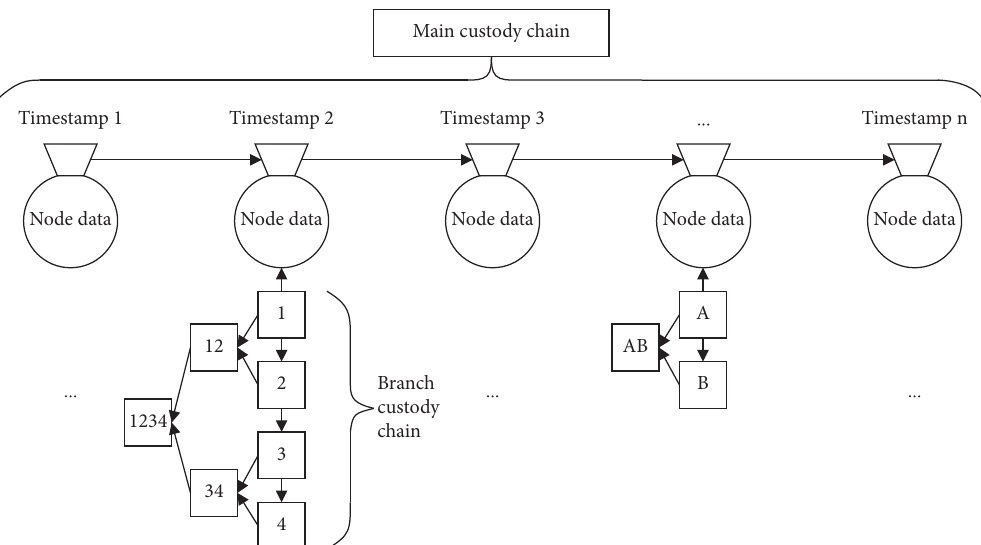
Figure 3: Architecture of the presented data preservation